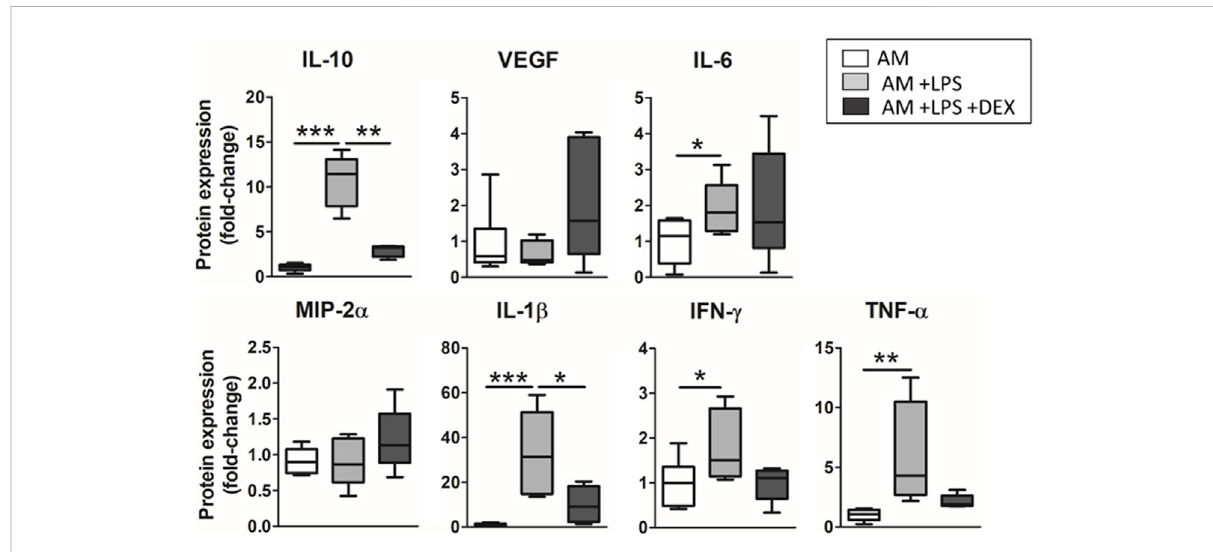
FIGURE 9 Anti-in fl ammatory effects of dexamethasone were studied in the advanced model. There was observed a general trend in recovering the expression levels observed before the in fl ammatory hit, which were statistically signi fi cant in the case of IL-10 and IL-1 β